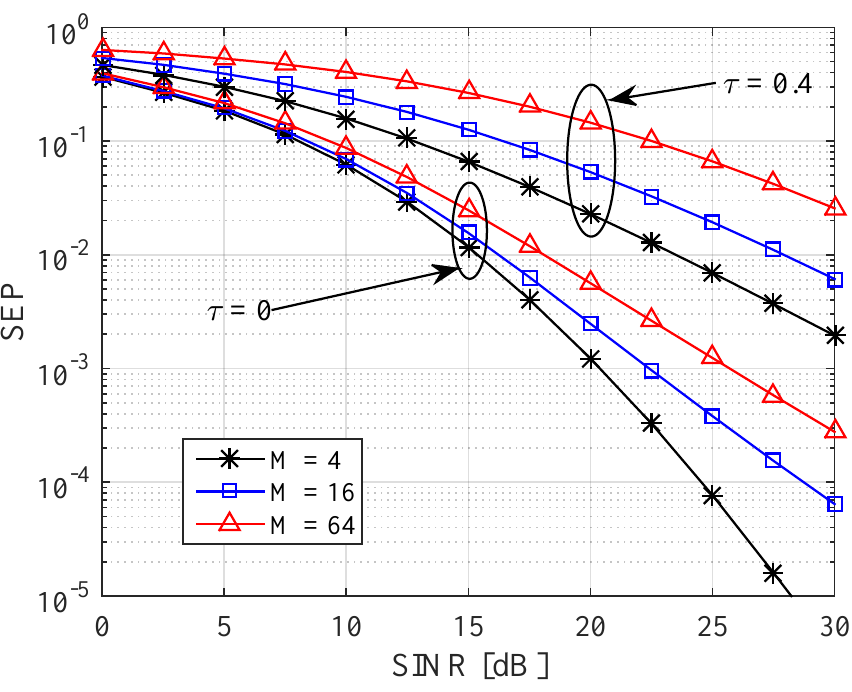
Figure 5. Symbol error probability of STBC-NOMA with U = 4 for perfect SIC, imperfect timing synchronization, and different modulation schemes (i.e., M = 4, 16, and 64).